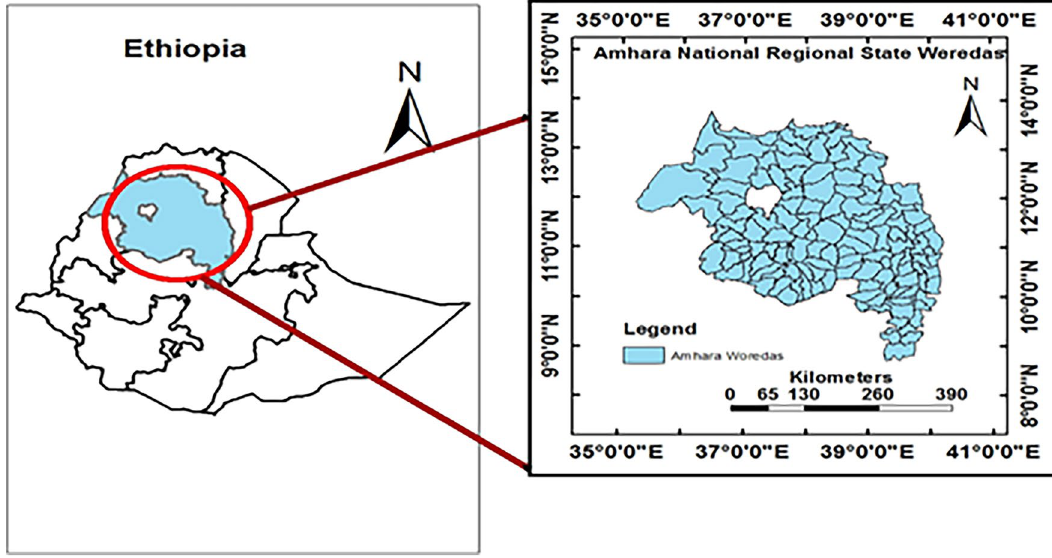
Figure 1. Study area map, districts in the Amhara National Regional State, Ethiopia in 2012 (ArcGIS, v10.3; https:// www. esri. com/ en- us/ arcgis/ produ cts/ arcgis- deskt op/ resou